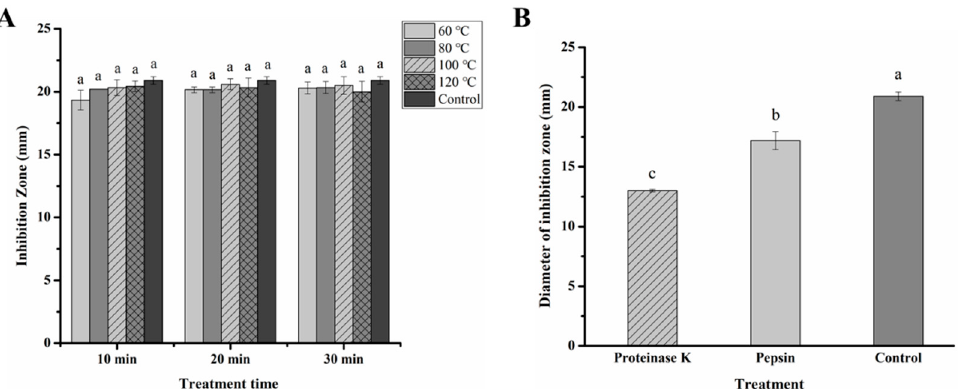
Figure 3. Sensitivity of fermentation product of L. paracasei WX322 from tomato juice to heat ( A ) and proteinase ( B ). ( A ), Fermentation product was heated at 60 °C, 80 °C, 100 °C, 120 °C for 10 min, 20 min, 30 min, respectively. ( B ), Fermentation product was treated by proteinases. Letters of a, b, c are significantly different by analysis of variance (ANOVA) and Tukey’s test ( p <